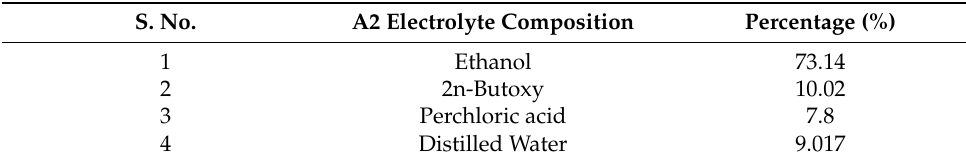
Table 1. Chemical composition of A2 electrolyte. S.